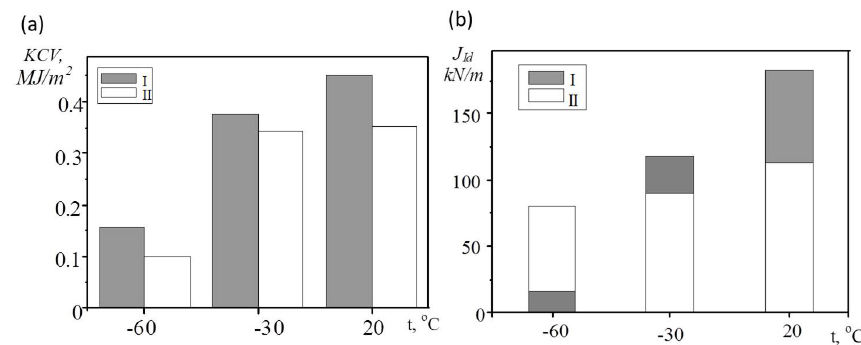
Figure 3. Dependence of impact toughness KCV (a) and J Id (b) on test temperature: I, II - specimen types according to Figure